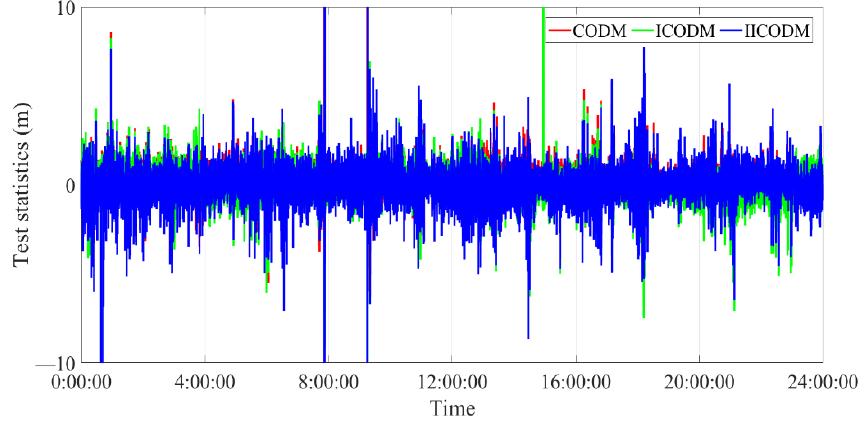
Figure 8. Time series of test statistics of CODM, ICODM and IICODM at SC04 station under case1.